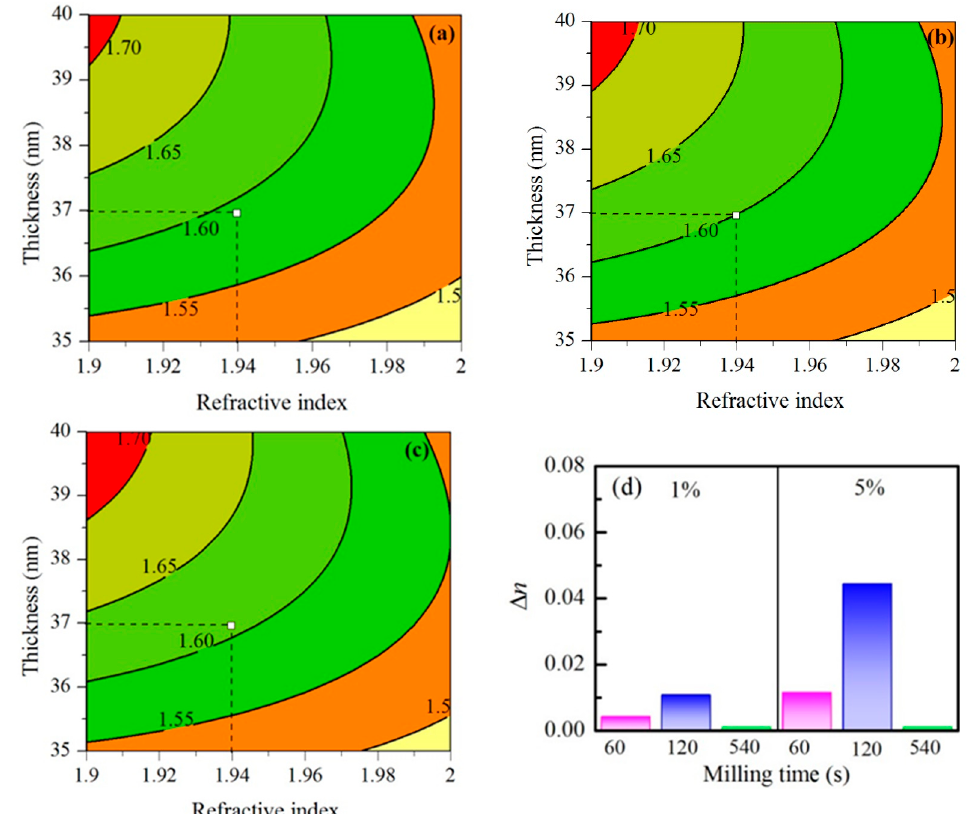
Figure 8. Contour plots ( a – c ) of calculated values of reflectance change Δ R max (%) for Nb 2 O 5 thin film doped with 5% of Na ‐ X 120 as a function of refractive index and thickness. The calculations were performed at a wavelength of 410 nm and Δ n = 0.0442 ( a ), Δ n = 0.0444 ( b ), and Δ n = 0.0446 ( c ). The white square with coordinates n = 1.94 and d = 37 nm presents the refractive index (at wavelength of 410 nm) and thickness of the film, respectively; ( d ) calculated values of Δ n using the contour plot approach.